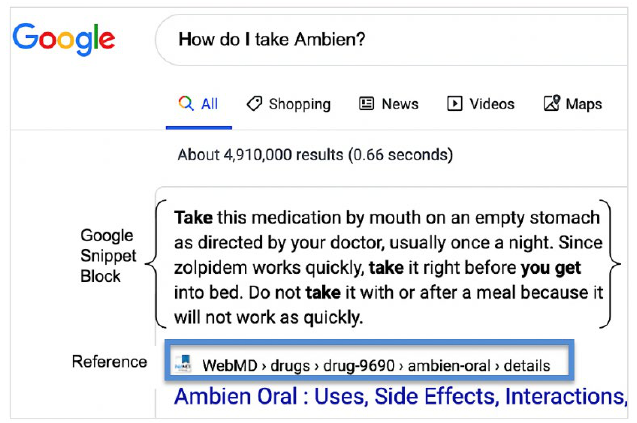
Figure 1 A screenshot of a Google snippet block when a question is entered into the search bar. Google and the Google logo are trademarks of Google LLC, and this article is not endorsed by or affiliated with Google in any way.